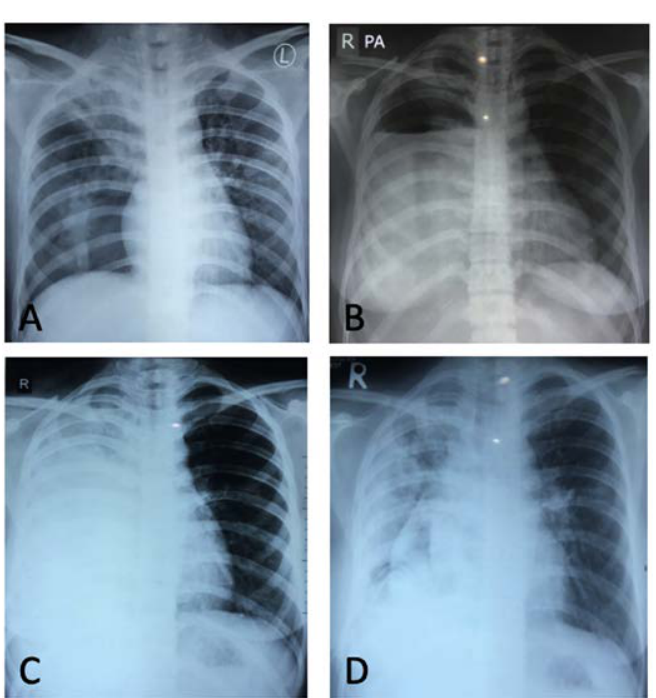
Fig. 1. (A). Chest X-Ray in a district hospital: right upper lobe fibroinfiltrate and pneumothorax; (B). Chest X-Ray in a tertiary hospital: air-fluid level in right hemithorax; (C). Increase of right homogenous opacity in a follow-up chest X-Ray; D. A follow-up chest X-Ray after tube thoracostomy: collapse line with thickening of pleural peel, fibroinfiltrate on the right upper